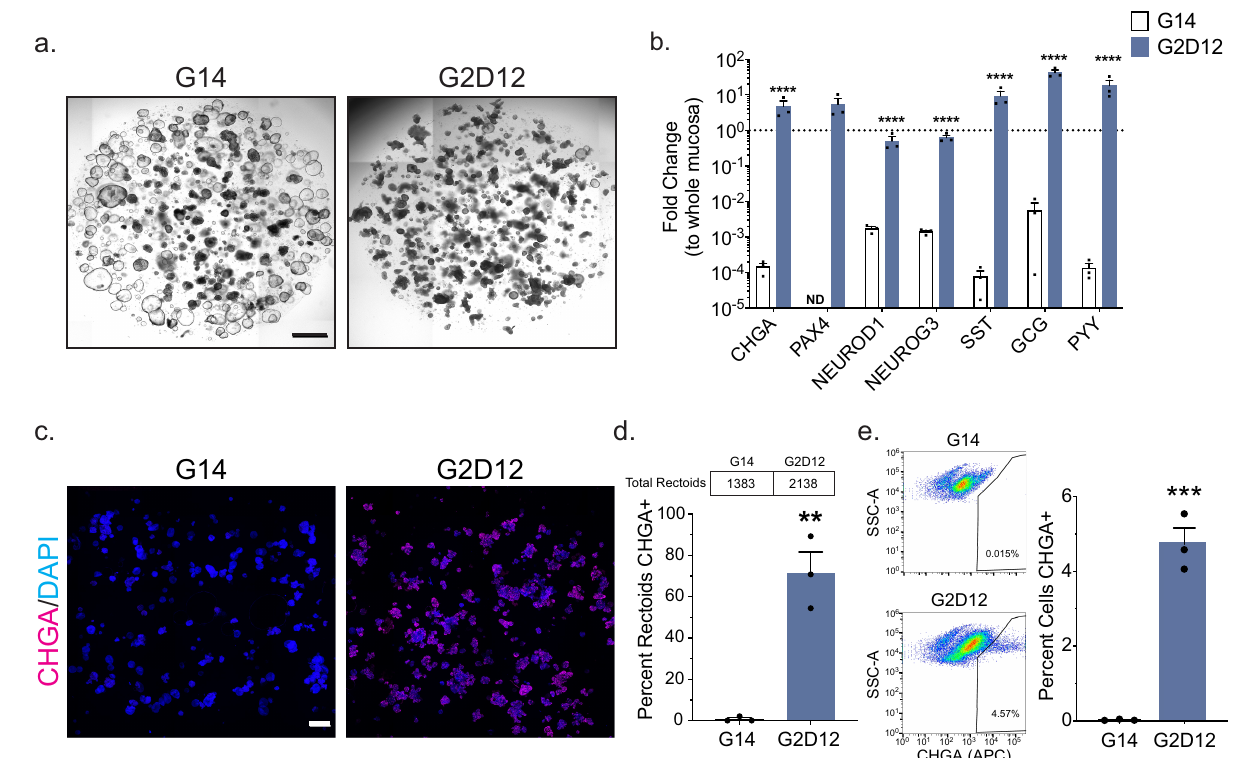
Fig. 8 Induction of the Enteroendocrine Lineage in Rectoids. a Representative light microscopy of rectoids (whole well) grown in G14 or G2D12. Scale bar = 1 mm. b qPCR analysis of EE markers of rectoids grown in either G14 or G2D12 compared to whole rectal mucosa (dotted line) and normalized to 18S. Representative experiment showing n = 3 wells for each condition from a single rectoid line. CHGA = chromogranin A, PAX4 = paired box 4, NEUROD1 = neuronal differentiation 1, NEUROG3 = neurogenin 3, SST = somatostatin, GCG = glucagon, PYY = peptide YY, ND = not detectable in one or more samples. **** p < 0.0001. c Representative immuno fl uorescence staining of CHGA (magenta) in rectoids (whole well) treated with G14 and G2D12. DNA (4 ′ ,6-diamidino-2-phenylindole (DAPI), blue). Scale bar = 1 mm. d Percentage of rectoids with CHGA staining in G14 and G2D12 treatments. Average results are from three different rectoid lines or passages. Table above graph shows the total number of rectoids examined per condition. ** p = 0.0022. e Left two panels: Representative fl ow cytometry plots of CHGA + cells from rectoids grown in G14 and G2D12. Right panel: Percentage of CHGA + cells per well. Representative experiment showing n = 3 wells from each condition from a single rectoid line. *** p = 0.0004. Bars show mean ± SEM; two-way ANOVA with Tukey correction for multiple comparisons ( b ); two-tailed unpaired t test ( d , e ). Each experiment repeated with at least three different rectoid lines. Speci fi c conditions were excluded from statistical analysis if the data from one or more samples were labeled as not detectable. Source data are provided as a Source Data fi